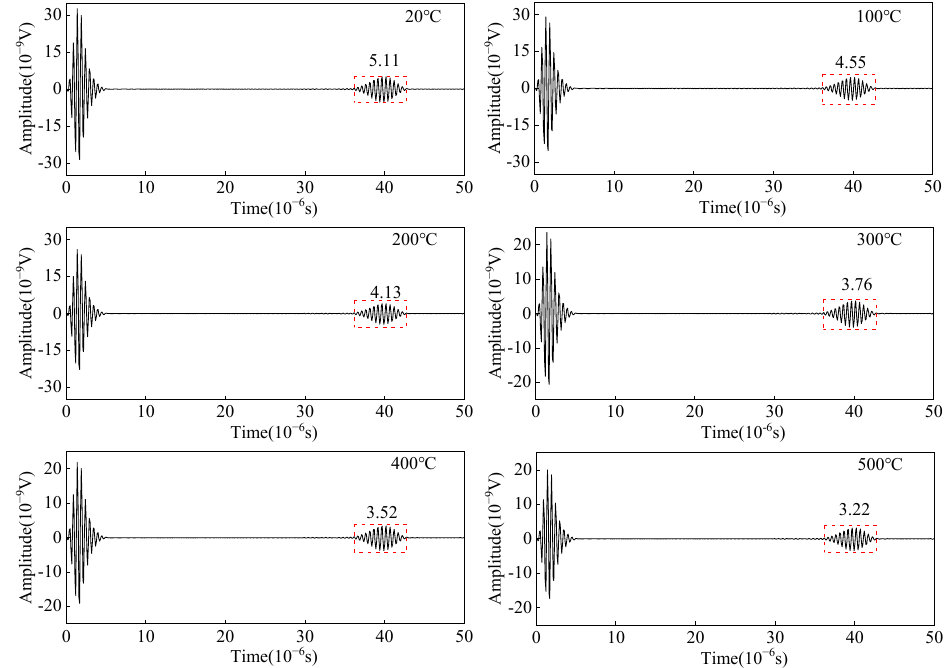
Figure 11. Open-circuit inducted voltage from angled SV wave EMAT in carbon steel specimens at different temperatures.